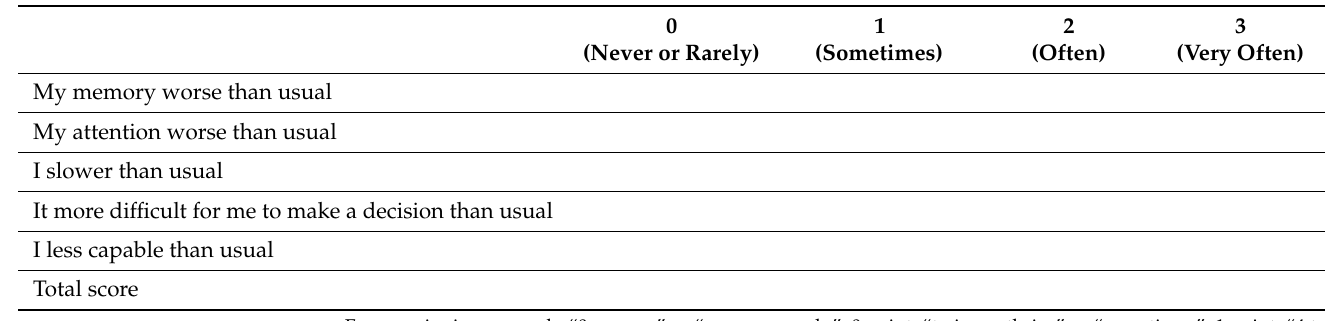
Table A1. Instruction: The following questions are used to valuate your recent cognitive